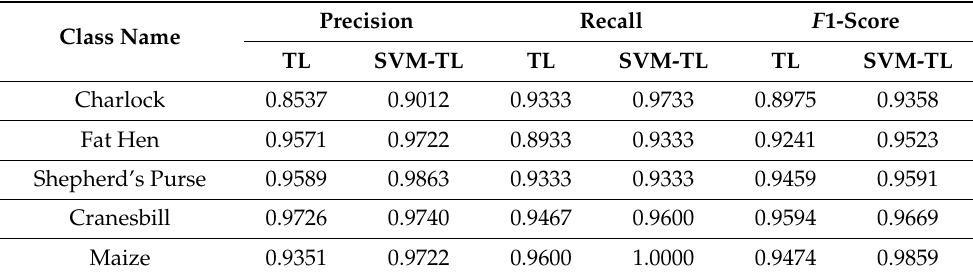
Table 4. Analysis of classification results of SVM on deep features of AlexNet . The SVM and GAN- SVM refer to the SVM models trained with the real image data, and combined real and artificial datasets, respectively.